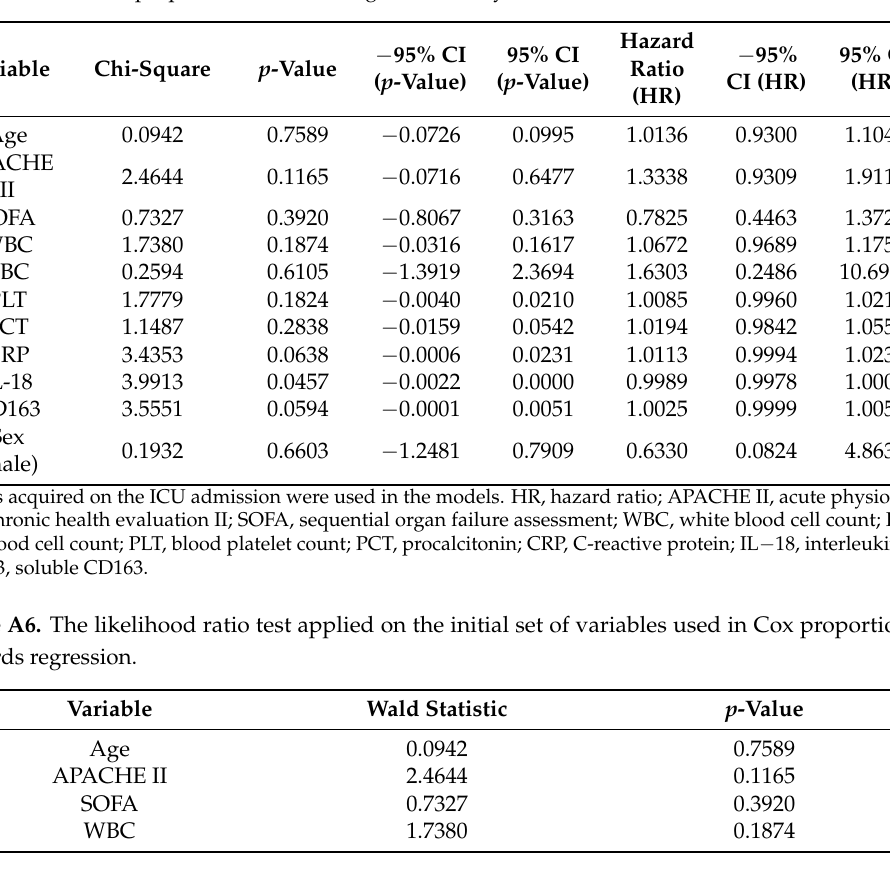
Table A5. The Cox proportional hazards regression analysis carried out on the initial set of variables.